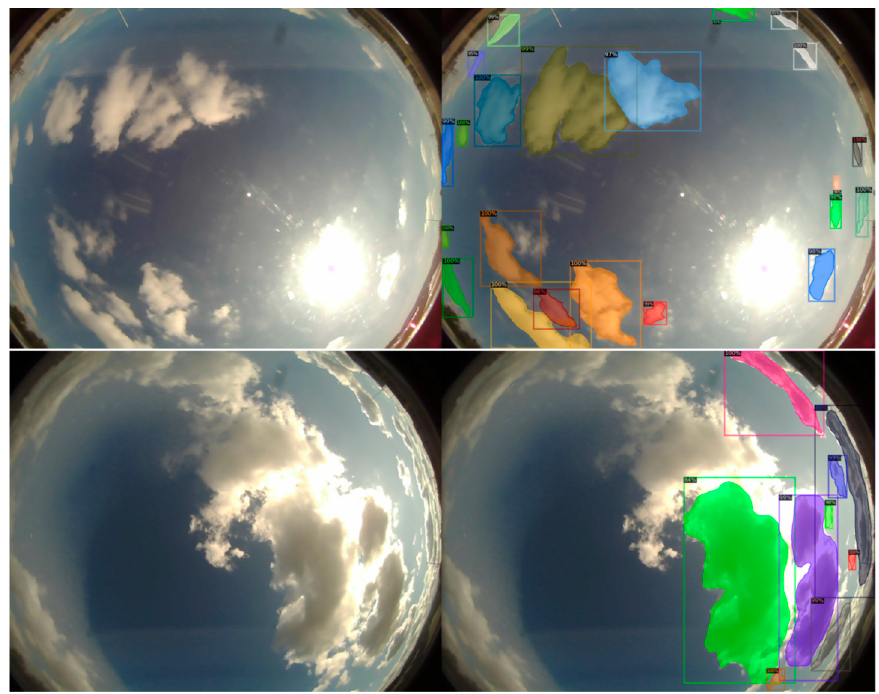
Figure 9. Visualization of the trained Mask R-CNN network using the test set data (left without a mask, right with mask, successful segmentation above, insufficient segmentation below).